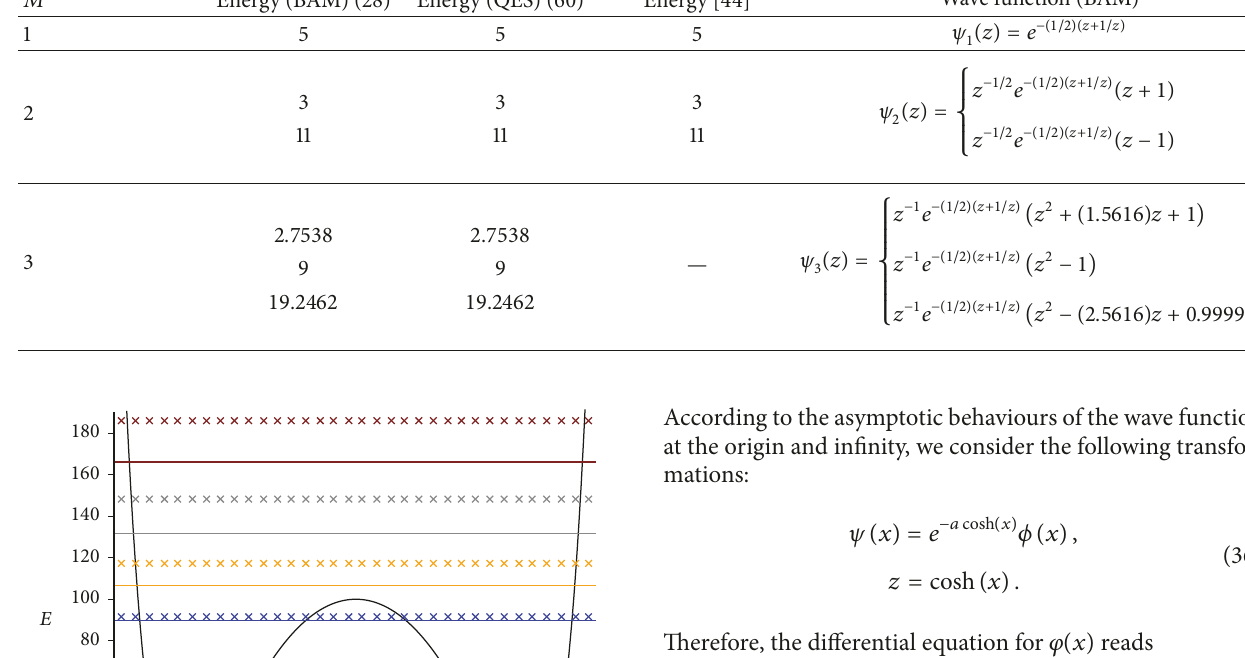
Table 2: Solutions of the first three states for the Razavy bistable potential with 𝜉 = 2 , where 𝑧 = 𝑒 2𝑥 . 𝑀